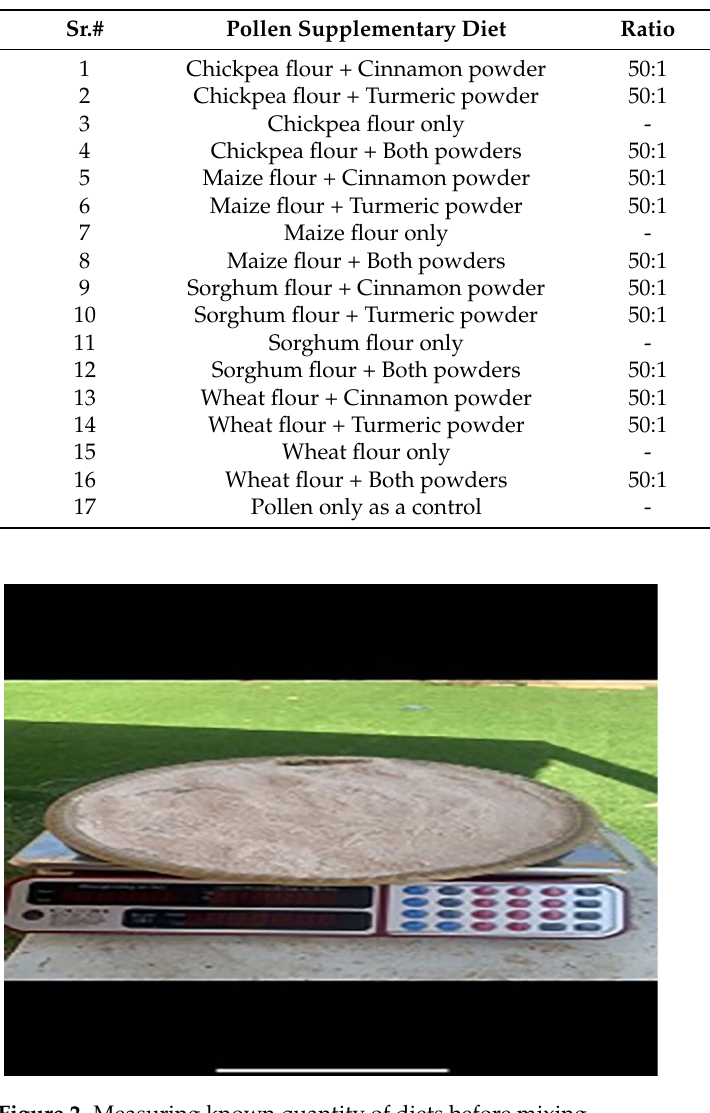
Table 1. Different supplement formulations.